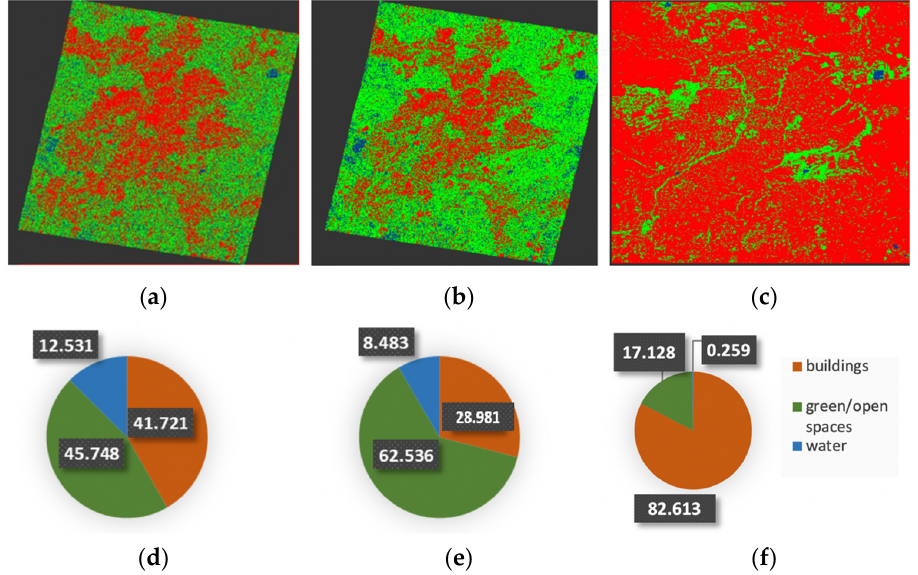
Figure 7. Comparison of Supervised Classifiers in Nicosia: ( a ) Random Forest—Sentinel-1; ( b ) Maxi- mum Likelihood—Sentinel-1; ( c ) Random Forest—Sentinel-2; ( d ) Land Cover—RF; ( e ) Land Cover— ML; ( f ) Land Cover—S2/RF.